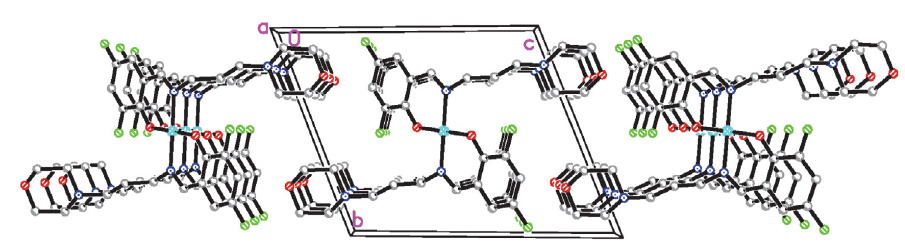
Figure 8. Molecular packing structure of complex 4 , viewed along the a axis. Table 3. Antimicrobial activities of the complexes with minimum inhibitory concentrations (μg mL –1 ) Tested material B.